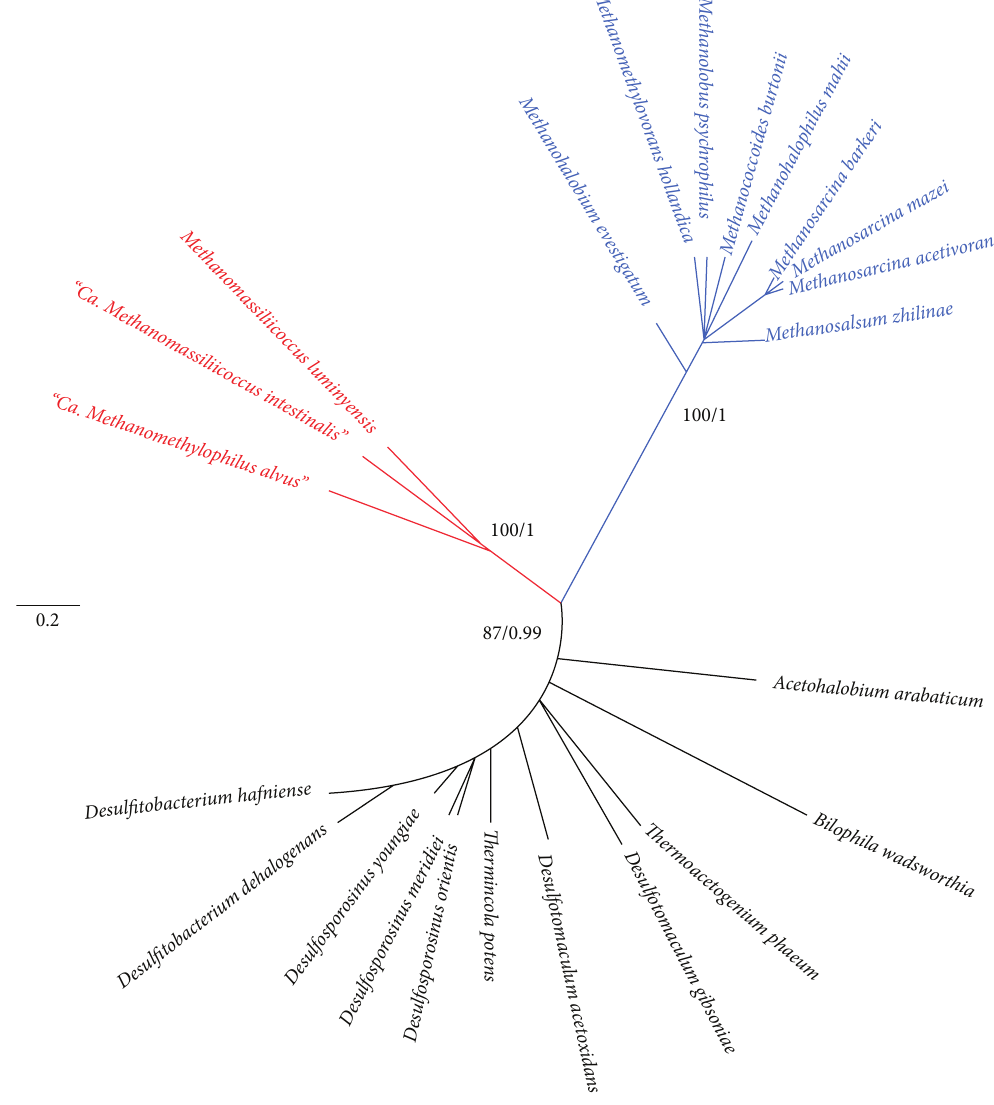
Figure 3: Phylogenetic trees of the pylSCD geneproducts. The phylogenetical analysis (PhyML) was performed from a concatenation (672 positions). See Sections 2 and 3 for more details. Individual trees are also reported in the additional file (supplementary Figures S1 to S3 with indication of the corresponding accession numbers). The 7th methanogenic order members are indicated in red, the Methanosarcinaceae in blue, and the bacteria in